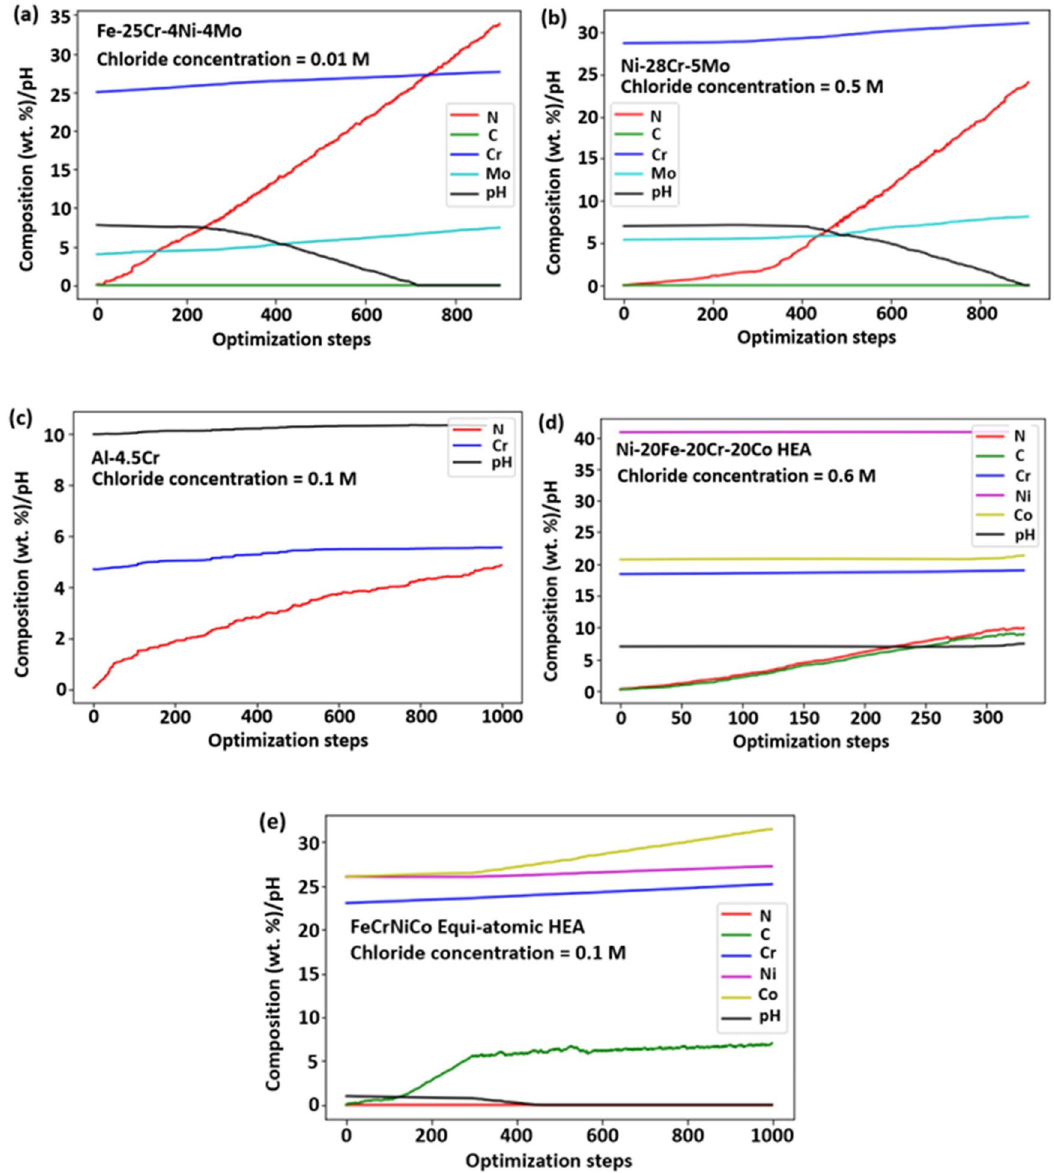
Fig. 3 Compositional change during different optimization sequences carried out while keeping the respective chloride ion concentrations fi xed. The initial conditions for each optimization sequence have been indicated. a Fe-25Cr-4Ni-4Mo ferritic stainless steel. b FCC Ni-28Cr-5Mo alloy. c Al-4.5Cr alloy. d FCC Ni-20Fe-20Cr-20Co high entropy alloy and e FCC equiatomic Fe-Ni-Cr-Co high entropy